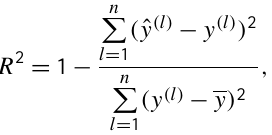
Table B1. Fitness statistics of the models on the training